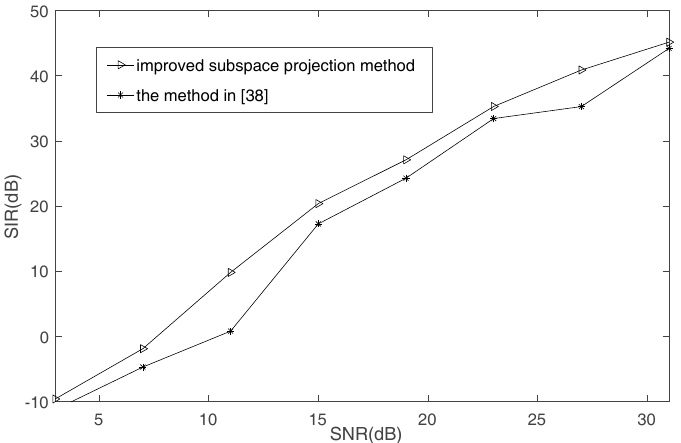
Figure 10. The SIR comparison of different recovered methods.